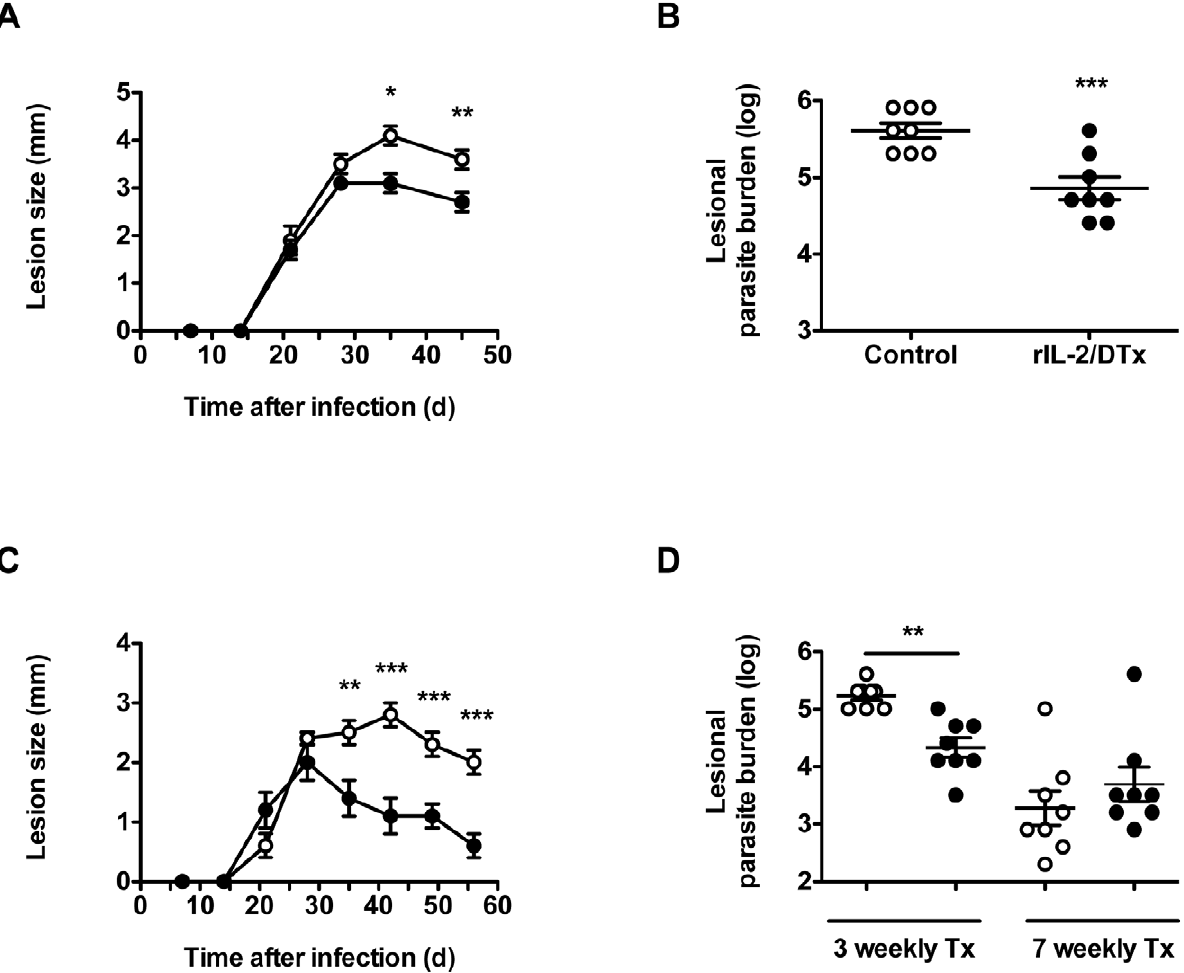
Figure 2. Treatment with rIL-2/DTx enhances resolution of experimental L.major infection. C57BL/6 mice were infected intradermally in both ears with 3 6 10 3 metacyclic L. major promastigotes. ( A , B ) Beginning 30 d after infection, mice were treated three times, at 5 d intervals, with normal saline (open symbols) or rIL-2/DTx (12 m g/kg; filled symbols). ( A ) Lesion size; ( B ) Lesional parasite burden, quantified 45 d after infection. ( C , D ) Beginning 7 d after infection, mice were treated at weekly intervals with normal saline (open symbols) or rIL-2/DTx (12 m g/kg; filled symbols), and lesion size ( C ) and parasite burden ( D ) was quantified 7 d after administration of the last indicated dose. Data represent means + / 2 SE of 8 mice/ group (with individual data points shown for parasite burden). ( A and C ) MANOVA P , 0.05; ( A–D ) Student’s t test; * P , 0.01, ** P , 0.005, *** P ,